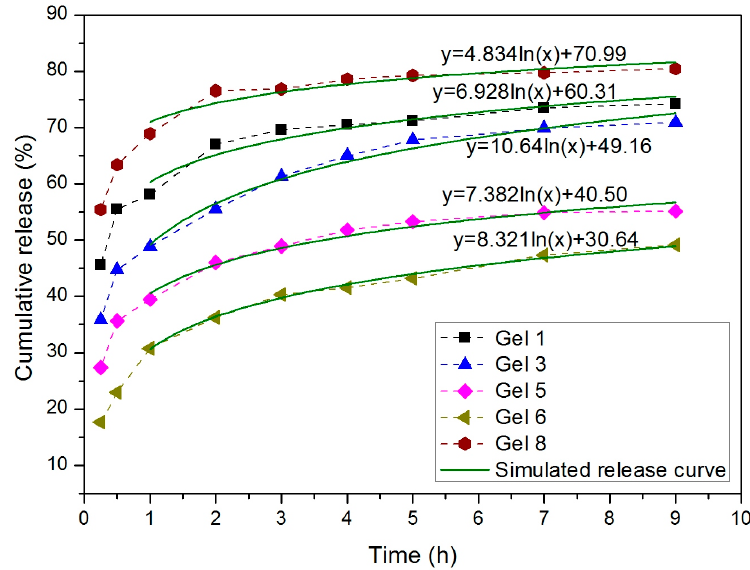
Figure 7. The release behaviors of 5-FU from gels in PBS (pH 7.4) at 37 °C and the simulated release curves.